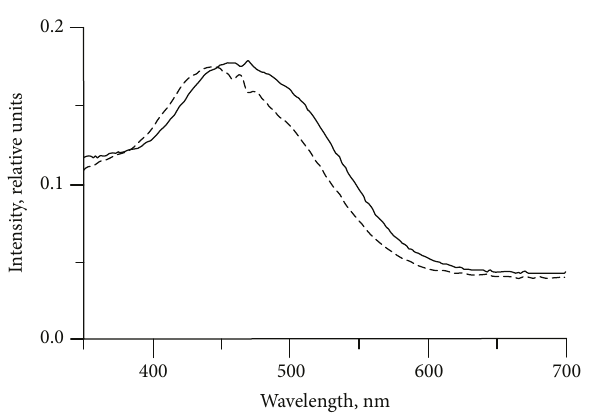
Figure 3: Absorbance spectra of OMS in the PVB fi lm before (dashed line) and after (solid line) incubation in the 10 -3 M Ba(ClO ) . 4 2 Table 2: The wavelength of the absorbance maximum for PCM with OMS before and after incubation with Ba(ClO Spectral characteristics